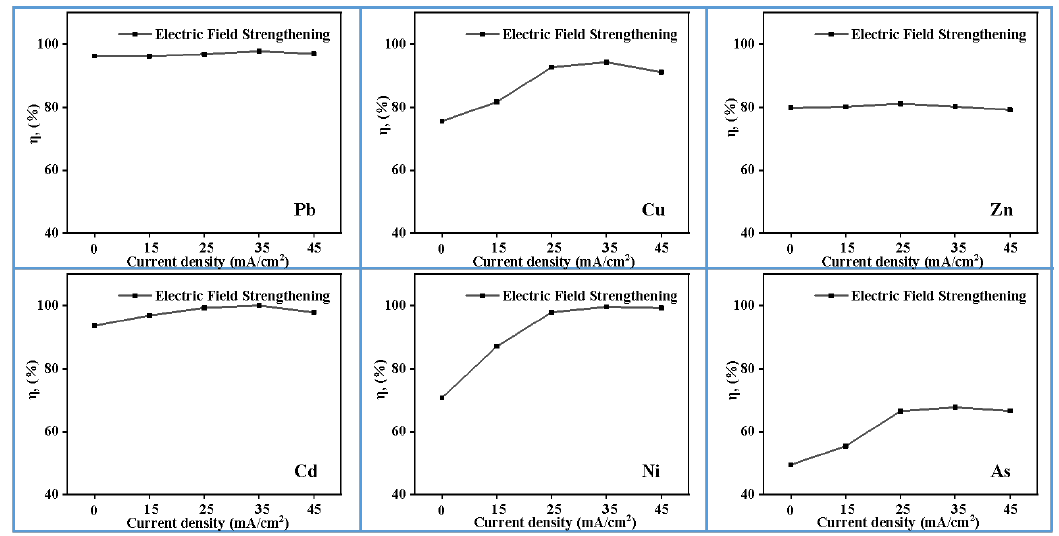
Figure 5. Effect of current density on heavy metals efficiency (0.5 mol/L EDTA, pH = 2, 4 h, 0 Hz). Figure 5. E ff ect of current density on heavy metals e ffi ciency (0.5 mol / L EDTA, pH = 2, 4 h, 0